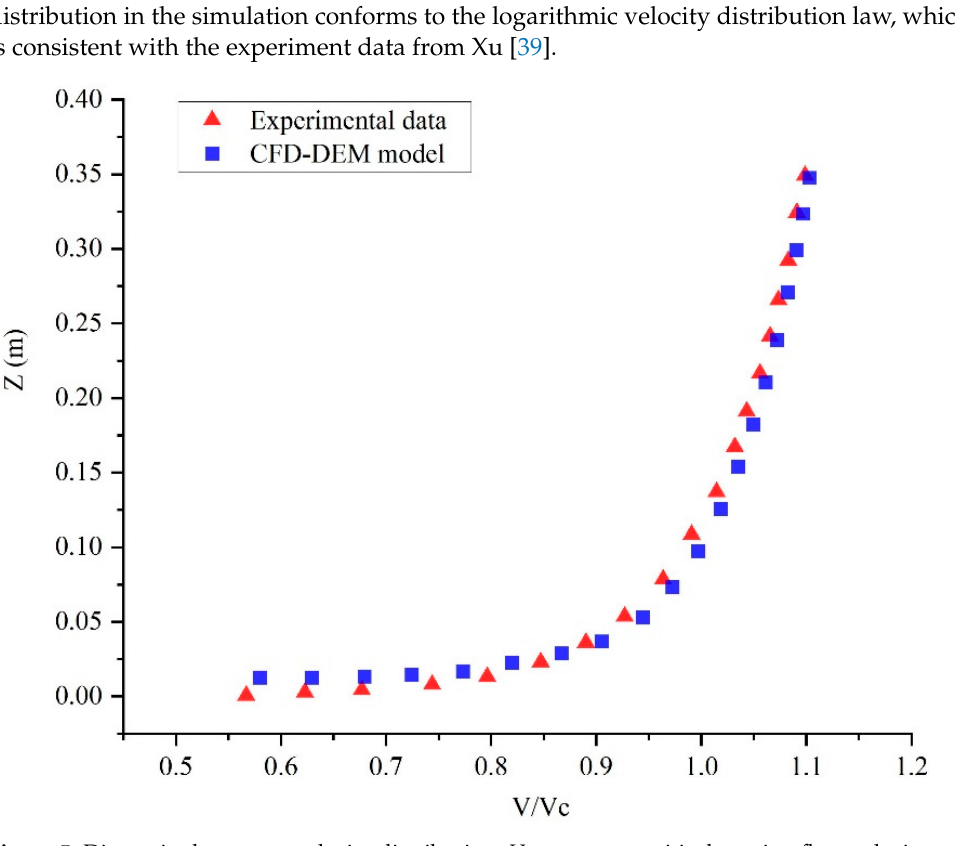
Table 1. Comparison of scour conditions.